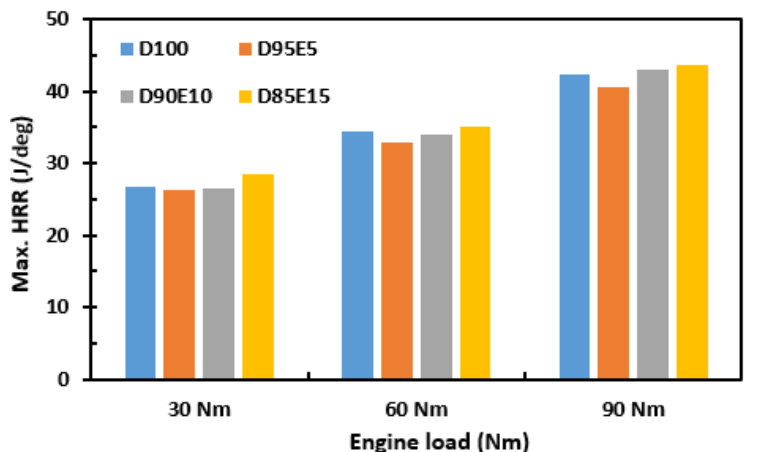
Figure 5. Maximum heat release rate for all test fuels according to various engine loads.